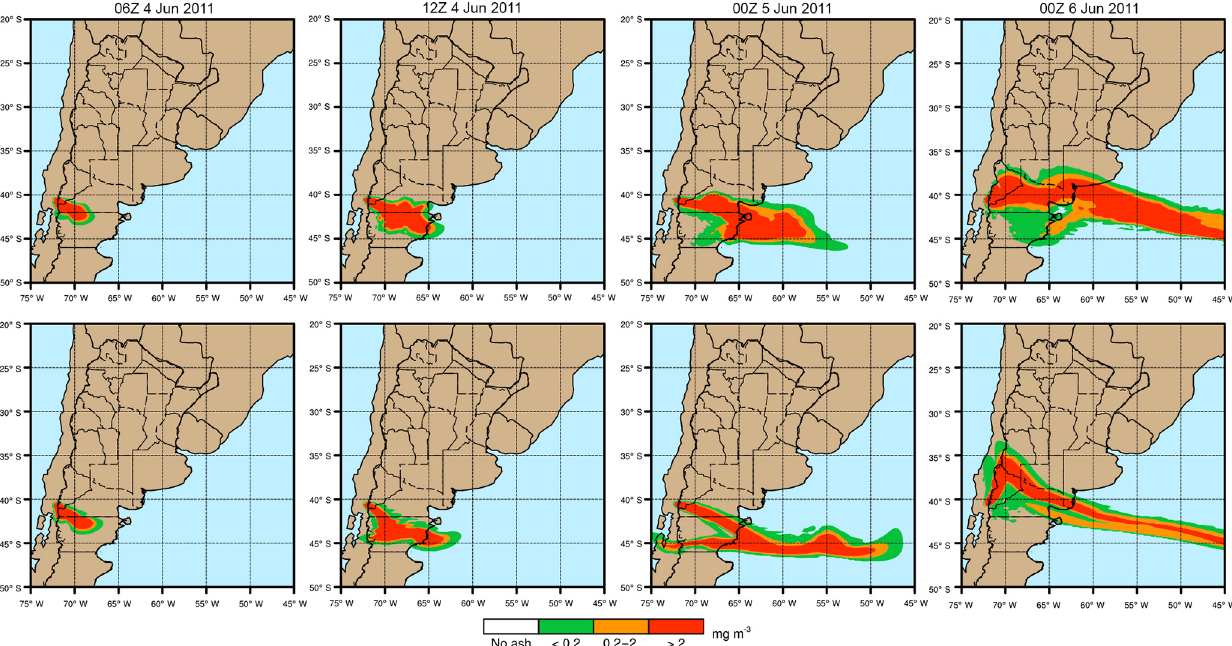
Figure 12. Ash hazard aviation guidelines applied for the 2011 Cordón Caulle application over time. Zones of low (green, ash concentra- tion < 0.2mgm − 3 ) , moderate (orange, ash concentration between 0.2 and 2mgm − 3 ) , and high (red, ash concentration above 2mgm − 3 ) concentration are displayed for FL50 (top) and FL200 (bottom). Table 5. Evaluation scores for the 2011 Cordón Caulle eruption application at the end of the 48h forecast with NMMB-MONARCH-ASH.